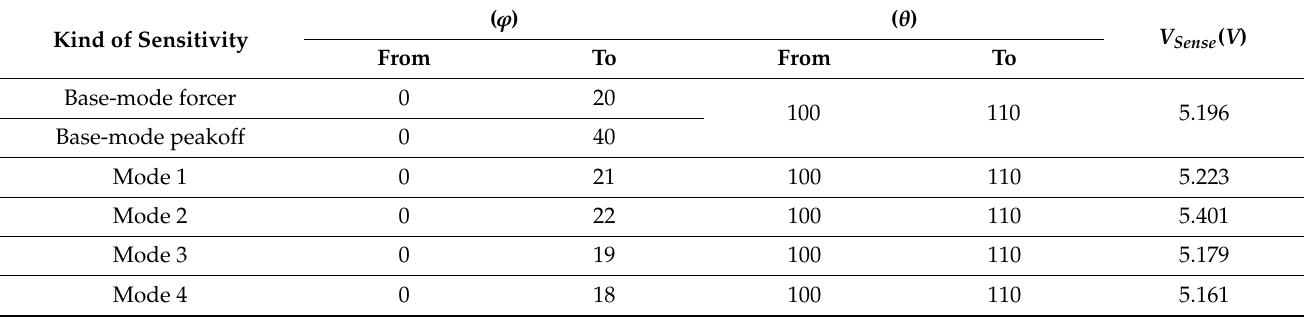
Table 6. Voltage sensed according to altitude location of electrodes (angle changes ( θ )).